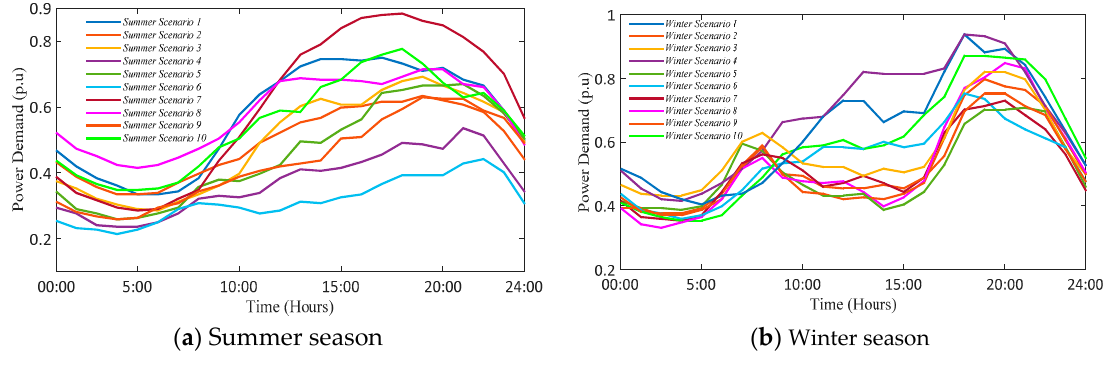
Figure 2. Scenarios representative subset for summer ( a ) and winter ( b ).